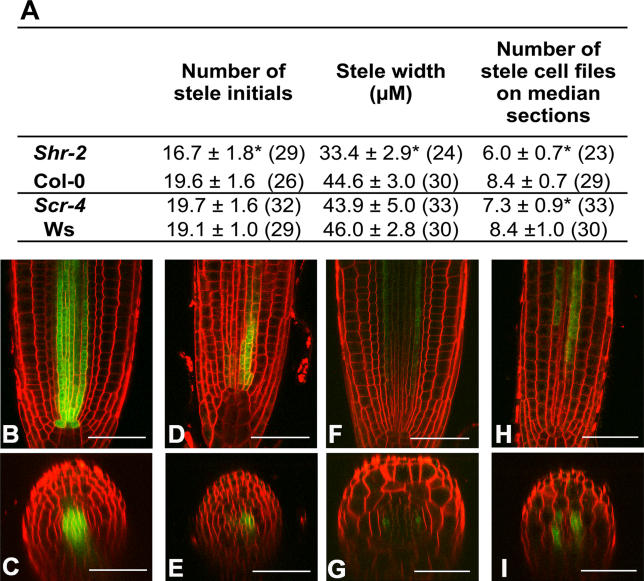
A Mutation in
SHR Affects the Development of the Stele
(A) Cellular parameters of stele development in
shr-2 mutants,
scr-4 mutants, and the corresponding wild-type plants (Col-0 for
shr-2 and Ws for
scr-4). The number of stele initials, the stele width 100 μm above QC, and the number of stele cell files visible on median longitudinal optical sections in the same region were measured in 4-d-old plants. The results ± standard deviation are indicated, as well as the number of plants analyzed in each case (in between parenthesis). The stars indicate values that are significantly different in the mutant compared to wild-type (
t-test:
p < 0.01).
(B–E) Expression of the Q0990 GFP marker in 5-d-old
shr-2 mutants and wild-type plants. (B and D) Longitudinal (B) and transverse (D) optical section of a wild-type root. (C and E) Longitudinal (C) and transverse (E) optical section of a
shr-2 mutant root.
(F–I) Expression of the J2094 GFP marker in 5-d-old
shr-2 mutants and wild-type plants. (F and H) Longitudinal (F) and transverse (H) optical section of a wild-type root. (G and I) Longitudinal (G) and transverse (I) optical section of an
shr-2 mutant root.
Scale bars: 25 μm.